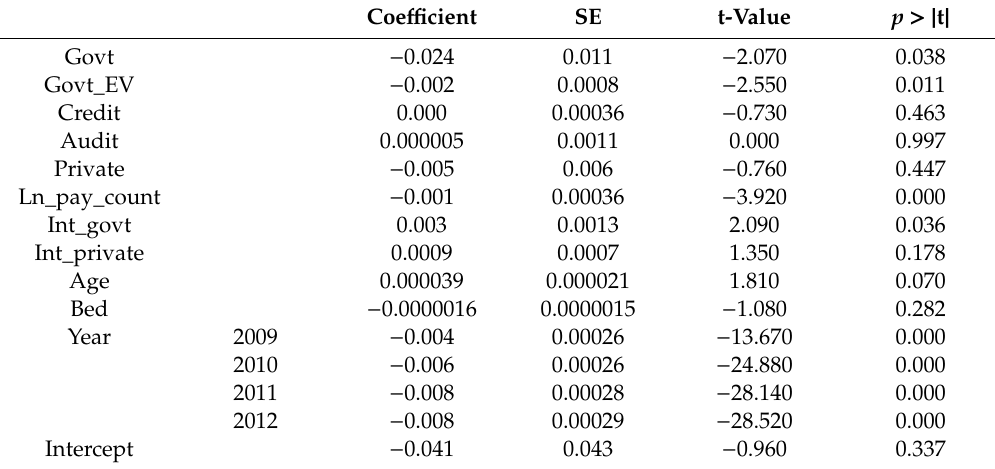
Table A5. Random e ff ects regression of publicness on financial